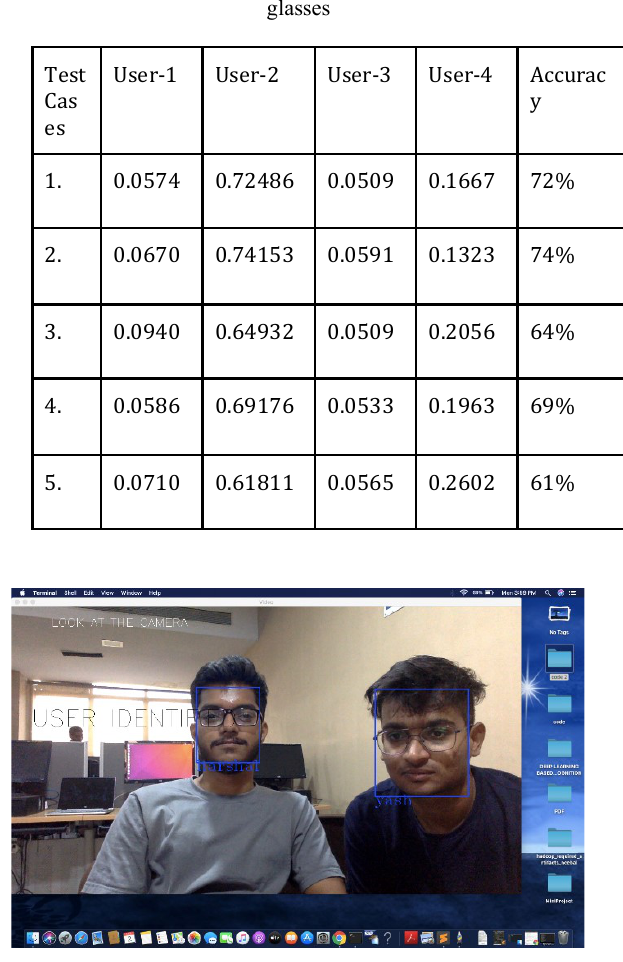
Fig 8: Surveillance system detecting multiple faces